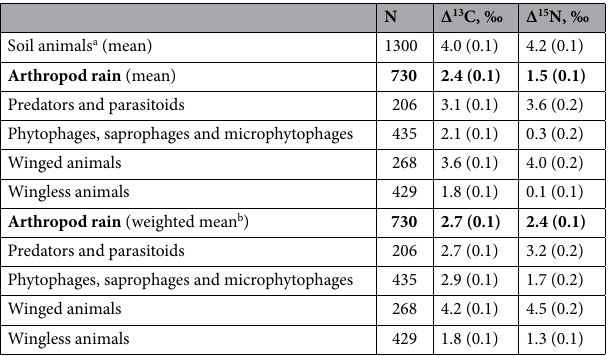
Table 1. Isotopic composition (litter-normalized Δ 13 C and Δ 15 N values) of soil animals (Potapov et al. 16 ) and of arthropod rain and its main components (mean and weighted mean values). Standard errors are shown in brackets. a Potapov et al. 16 . b According to the Eq. (3).